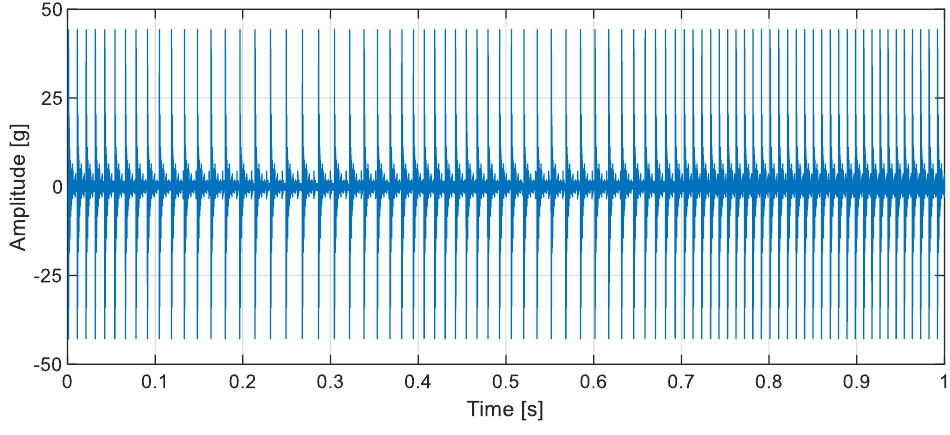
Figure 11. Variable-speed pulses.